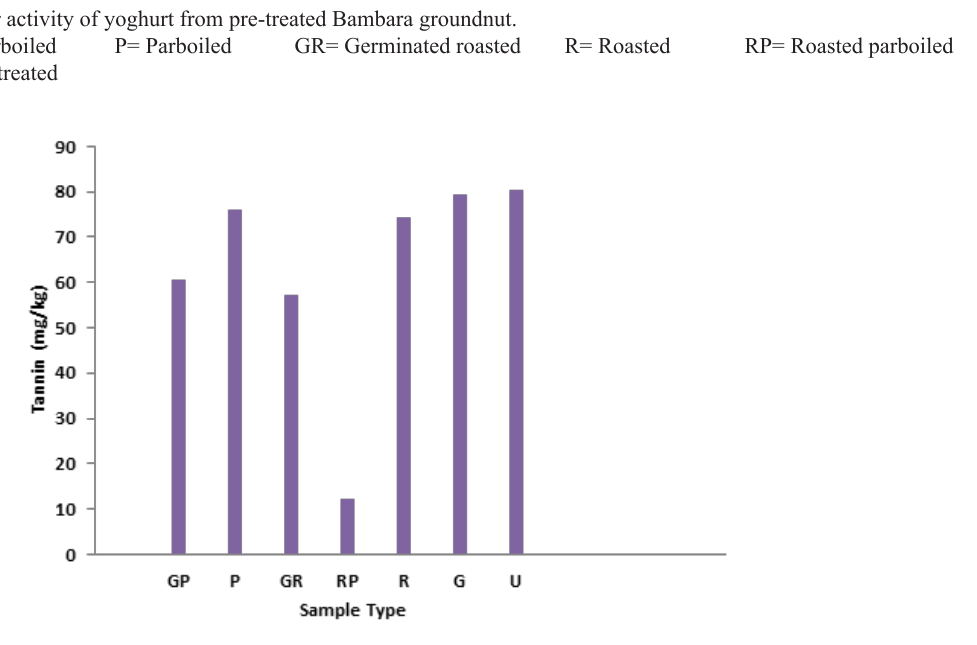
Figure 3: Tannin content of yoghurt from pre-treated Bambara